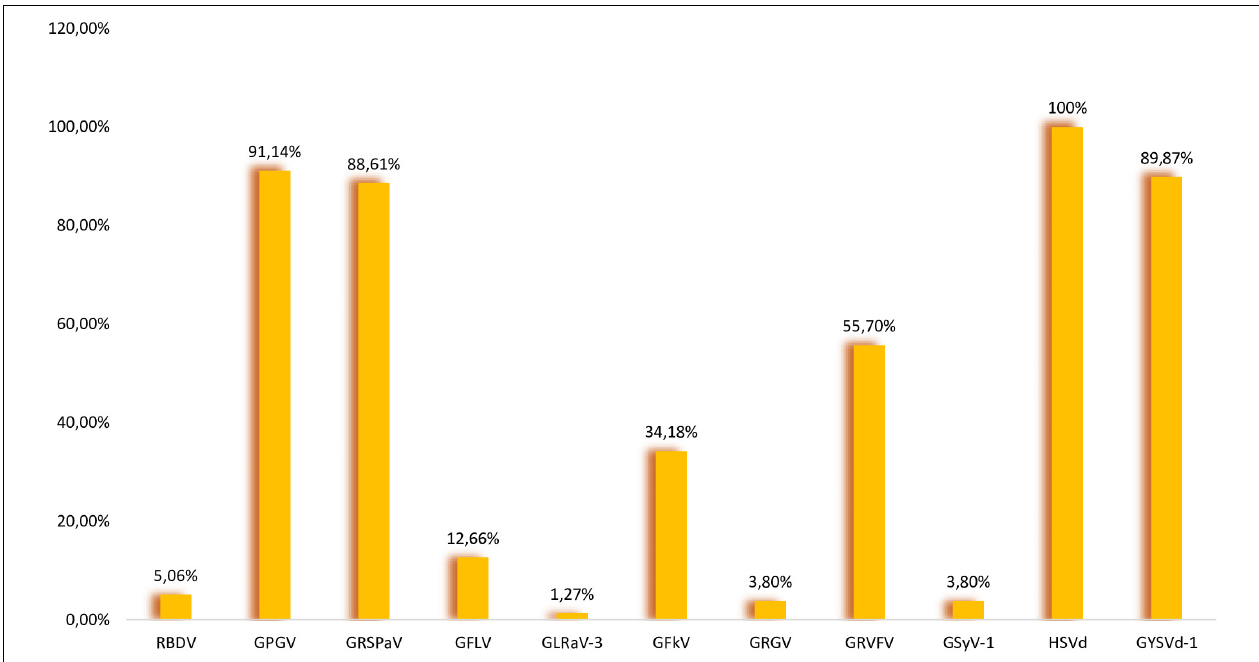
FIGURE 1 | Prevalence of nine viruses and two viroids in analyzed